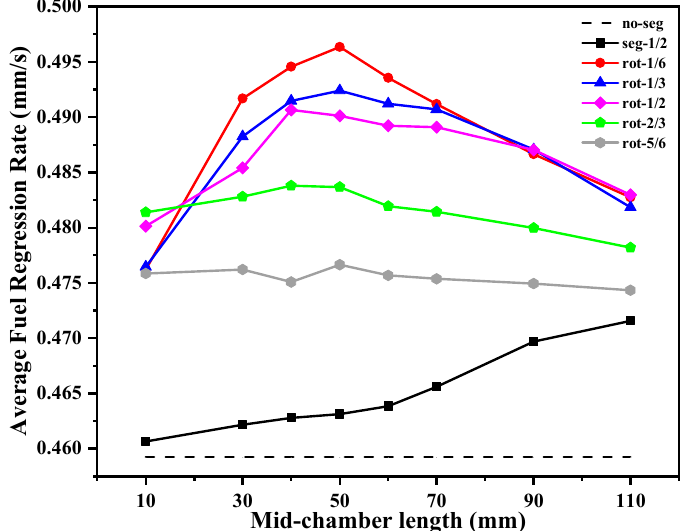
Figure 26. Average fuel regression rates in the aft-section grain for various cases.